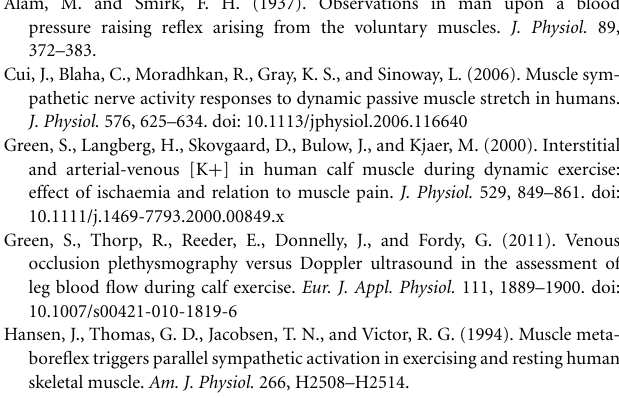
recovery.Asterisk( ∗ )indicatessignificantlydifferent( P < 0 . 05)fromtheresting responses before contraction. Cross ( + ) indicates significantly different ( P < 0 . 05) from the 10 to 30% MVC responses at the specified time. Hat ( ∧ ) indicatessignificantlydifferentfrom10%MVCresponsesatthespecifiedtime. These contrasts were based on post-hoc , two-tailed pairwise